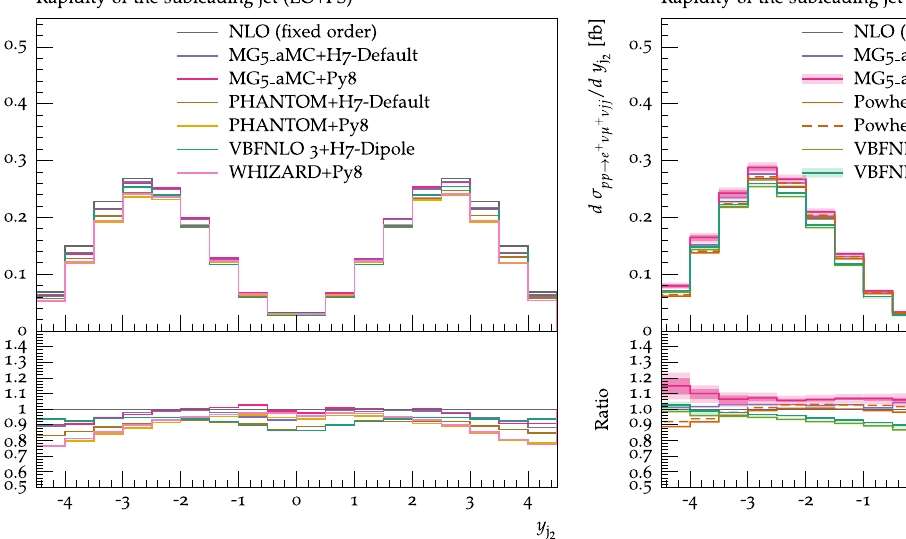
Fig. 18 Differential distribution in the rapidity of the second-hardest jet from predictions matched to parton showers, at LO (left) or NLO (right) accuracy (upper plot), compared with the fixed-NLO result computed with VBFNLO (lower plot). At NLO+PS accuracy, for VBFNLO + Herwig7- Dipole , the three-point scale uncertainties are